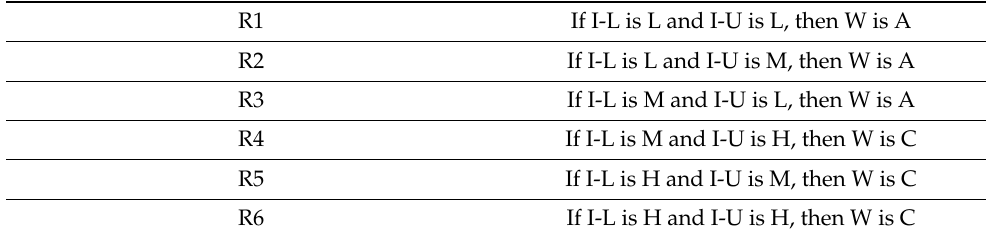
Table 1. Fuzzy inference rules for fuzzy stretching.